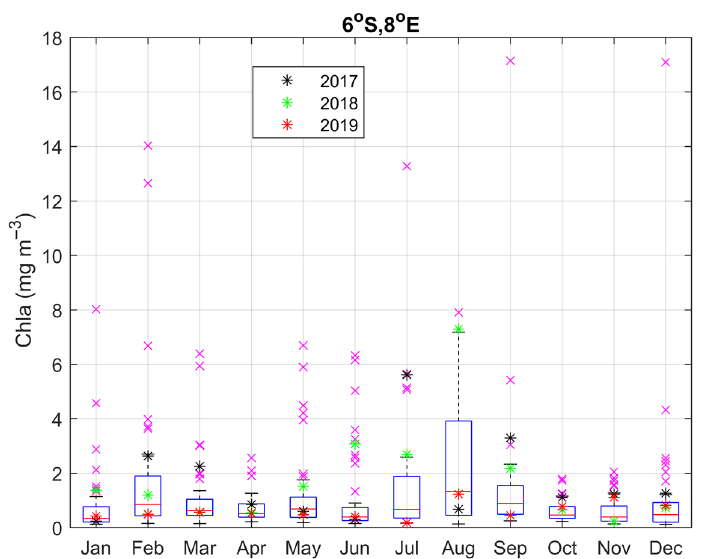
Figure 7. Distribution of MODIS chlorophyll at 6° S, 8° E grouped by month using data from 2002 to 2019. The central mark of the box corresponds to the median with the bottom and top edges of the box indicating the 25th and 75th percentiles. The whiskers extend to the extreme data points and the crosses are considered as outliers.